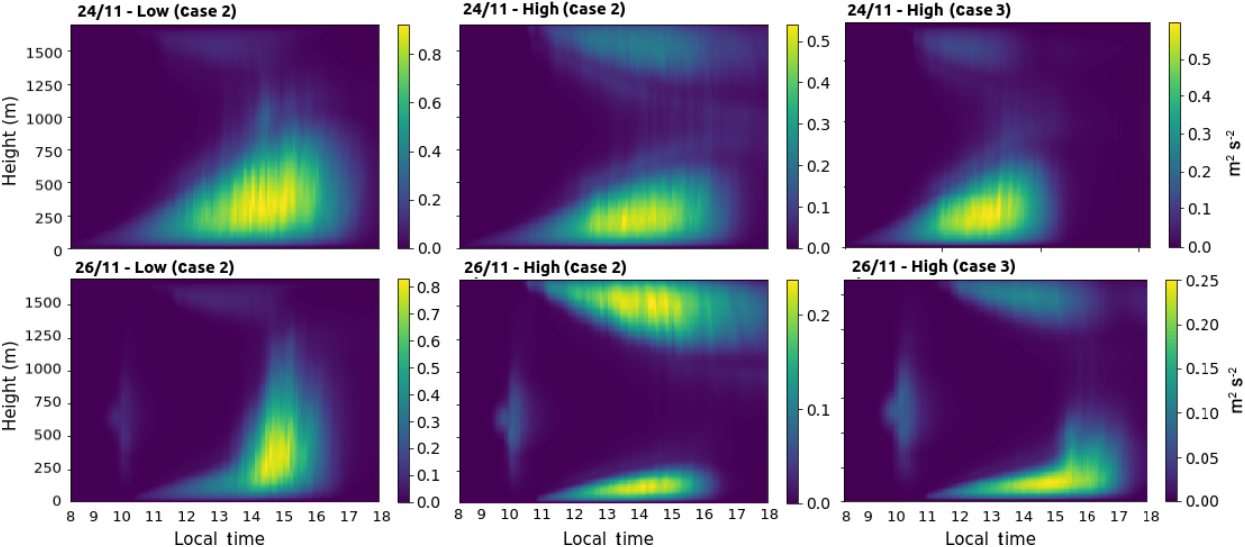
Figure 9. Variance in vertical velocity ( σ 2 w ) on 24 and 26 November for case 2 (low and high aerosol loading) and case 3 (high aerosol loading).